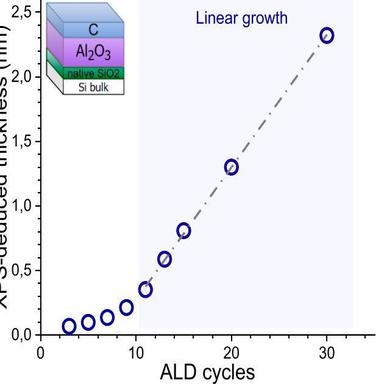
Al2O3 thickness as a function of the number of ALD cycles for chemical SiO2 and HF-last sample preparation as determined by pARXPS (circles) and WDXRF (triangles).